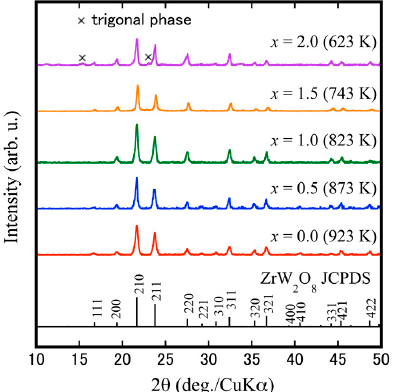
Figure 8. XRD results of cubic-ZrW 2 − x Mo x O 8 bulk ceramics.